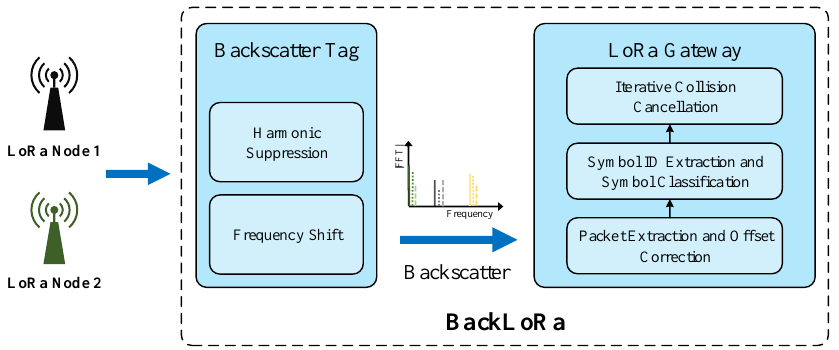
Figure 5. BackLoRa